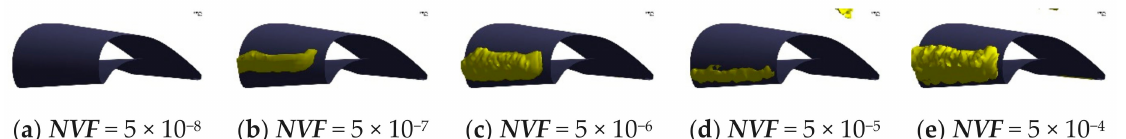
Figure 14. Bulk interphase mass transfer rate on stator blade at stall under various nuclei volume fractions.